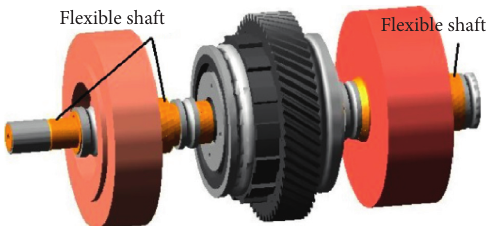
Figure 13: The rigid-flexible coupled dynamics